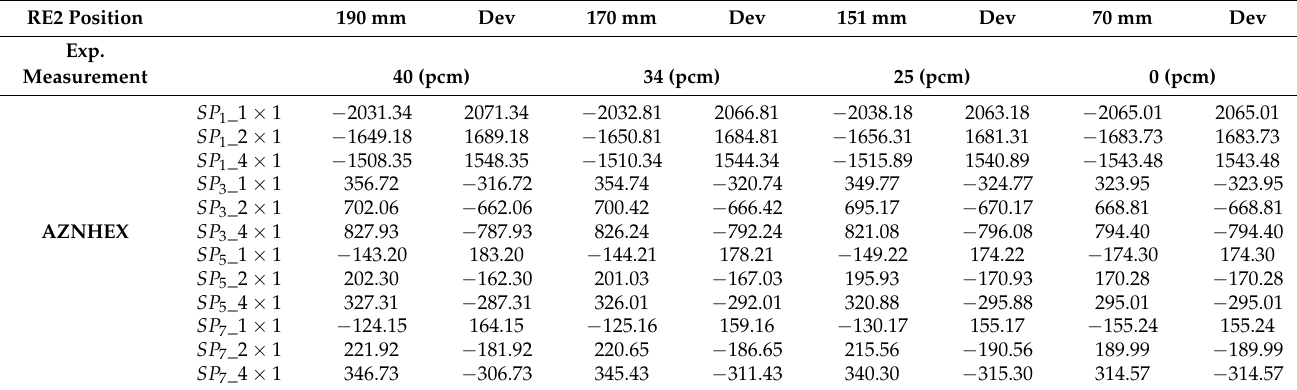
Table 7. Reactivity values and deviation in pcm from AZNHEX calculations with radial refinement and experimental data.